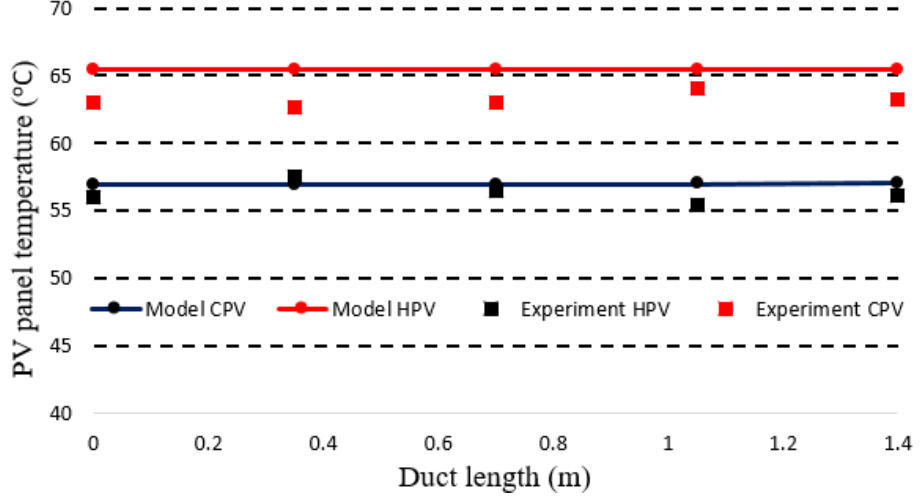
Figure 11. Experimental and simulated cooled and reference PV temperatures on 20 June at 14:05 (G = 797.88 W/m 2 , T am = 42.25 ◦ C, temperature ( T ai ) = 43.72 ◦ C, inlet water temperature ( T li ) = 25 ◦ C, wind speed (WS) = 1.2 m/s, RH = 7.99%,